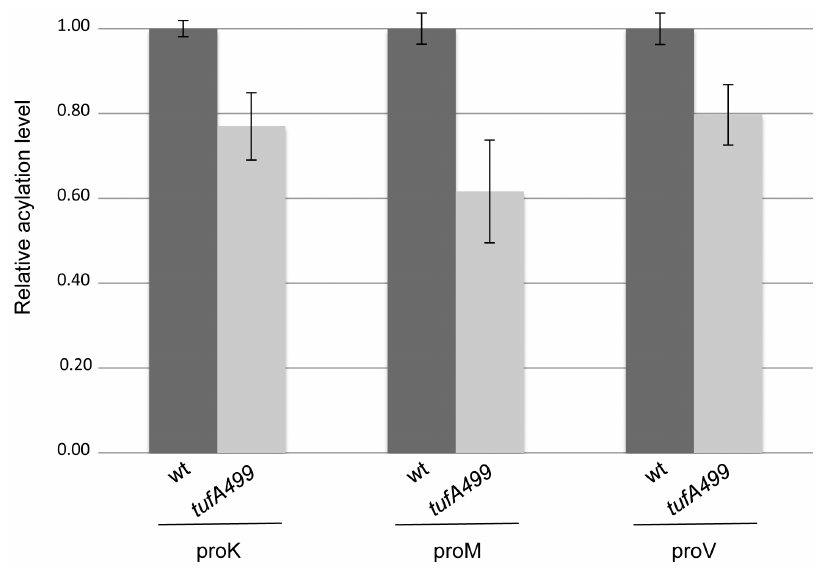
Figure 5. Proline tRNAs are less acylated in the slow-growing tufA499 mutant. Northern blot measurements of aminoacylation levels of the proline isoacceptors, in wild-type (TH7507) and tufA499 mutant (TH7509). Values are averages of four or five independent measurements and normalized to the wild-type, standard deviation shown as error bars. The differences between the wild-type and the tufA499 strains are statistically significant according to an unpaired t-test, proK: p=0.0007, proM: p=0.0010, proV: p=0.0027.